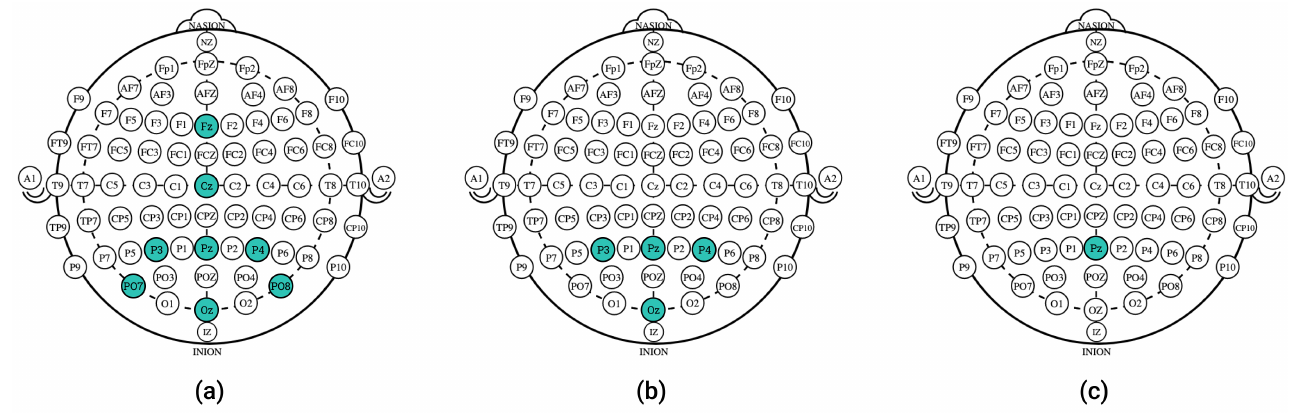
Figure 4. EEG electrodes placement on a scalp: ( a ) 8-channel data experiments; ( b ) 4-channel data experiments; ( c ) single- channel data